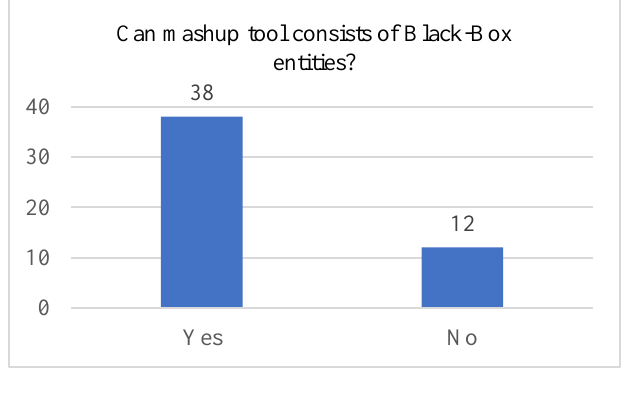
Fig. 7. Mashup tool consists of Black-Box entities